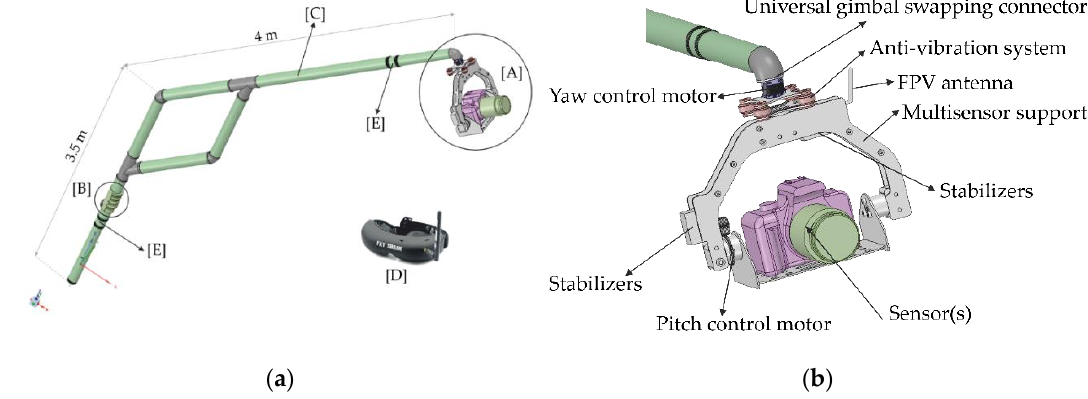
Figure 1. ( a ) General arrangement of the close-range pole-photogrammetric system and its main units: [A] self-stabilizing platform, [B] control system, [C] structure, [D] remote vision system with wired and wireless connection and [E] telescopic extenders. ( b ) Detail and mechanisms of the platform.